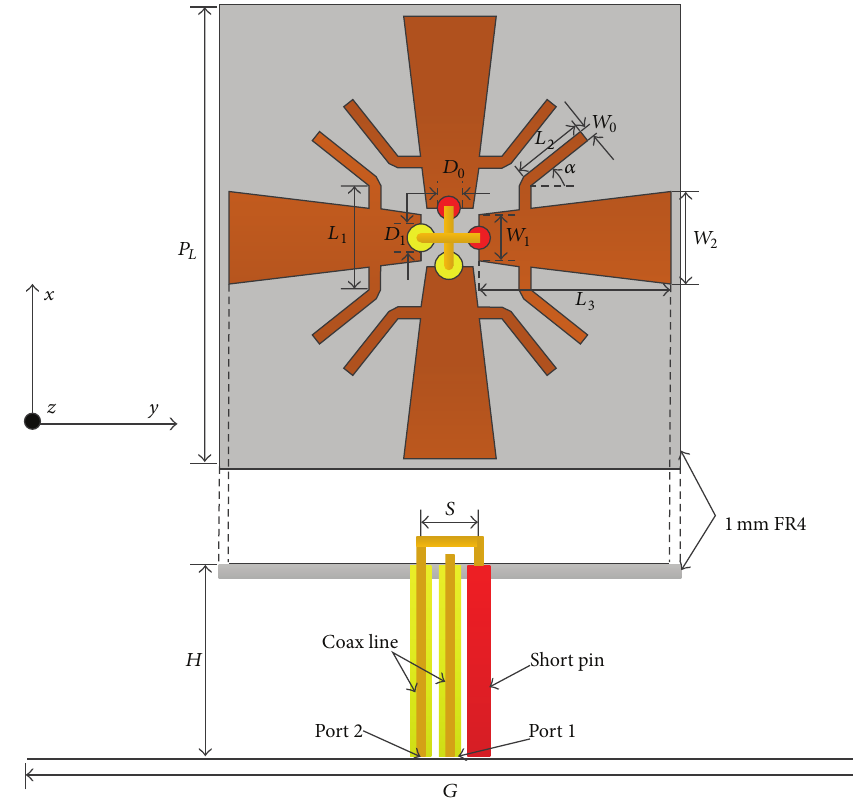
Figure 1: Geometry of the proposed antenna with the detailed design parameters.